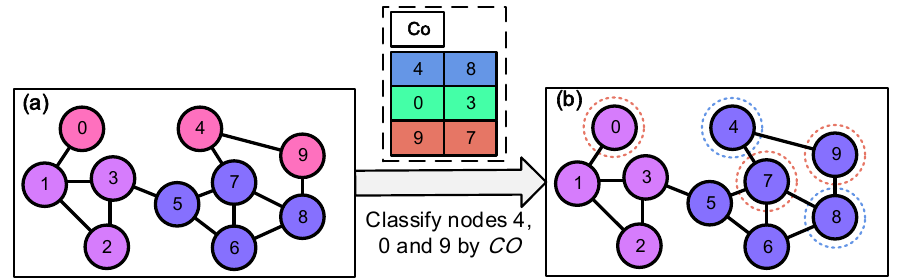
Figure 5. Population initialization based on the elite structure phase and the fast sorting phase. ( a ) Preliminary division of the network. ( b ) Initial partition of the